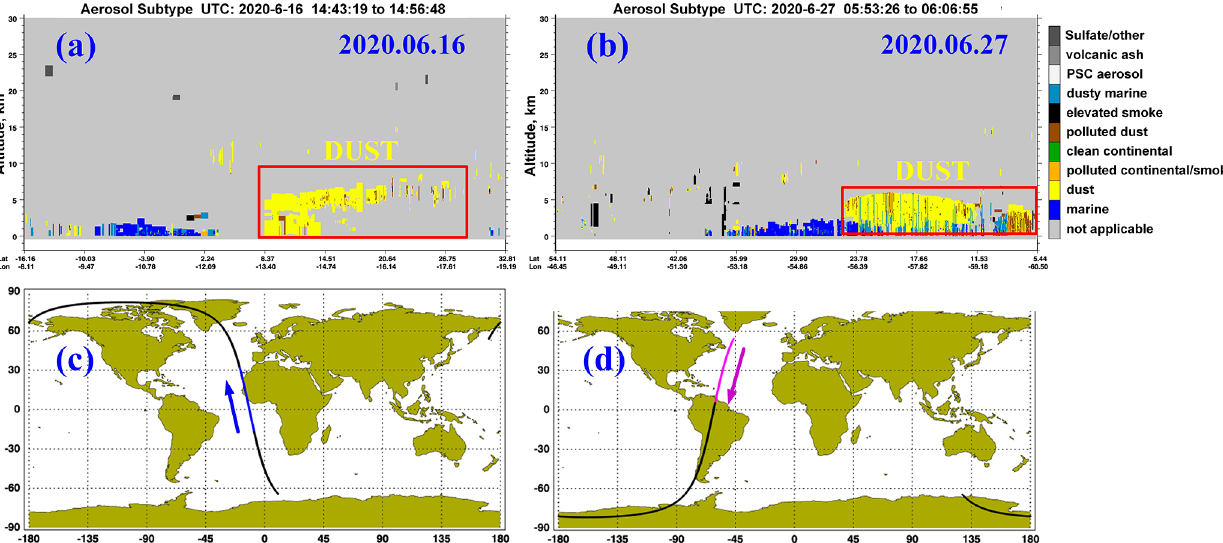
Figure 4. Vertical feature mask from CALIPSO L2 product (a) on 16 June 2020 over the west coast of Africa and the eastern Atlantic and (b) on 27 June 2020 over the western Atlantic (around the east coast of America). Panels (c) and (d) show the corresponding CALIOP scanning tracks of (a) and (b) respectively, the arrows in which indicate the motion direction of CALIPSO (https://www-calipso.larc.nasa. gov/products/lidar/browse_images/production/, last access: 24 March